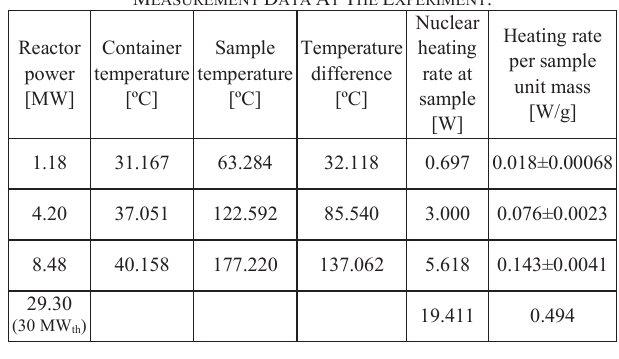
TABLE 2 M EASUREMENT D ATA A T T HE E XPERIMENT